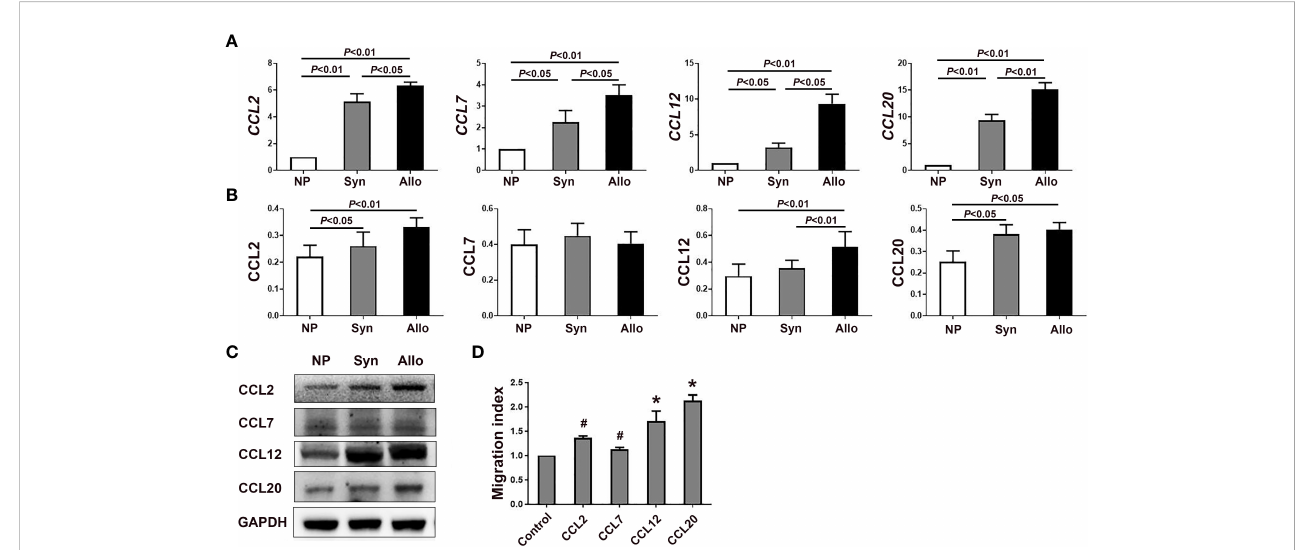
FIGURE 3 mRNA and protein levels of chemokines in the deciduae of syngeneic and allogeneic mice. (A) Levels of CCL2 , CCL7 , CCL12 and CCL20 mRNA in the deciduae of syngeneic and allogeneic mice are shown (n = 6). (B) Levels of proteins CCL2, CCL7, CCL12 and CCL20 in the deciduae of syngeneic and allogeneic mice are shown. (C) One representative western blot experiment of the protein levels of CCL2, CCL7, CCL12 and CCL20 is shown. (D) Chemotactic effects of chemokines CCL2, CCL7, CCL12 and CCL20 on thymus Treg cells. Data are presented as mean ± SD (n = 6). * p < 0.01, # p < 0.05 vs the control group.